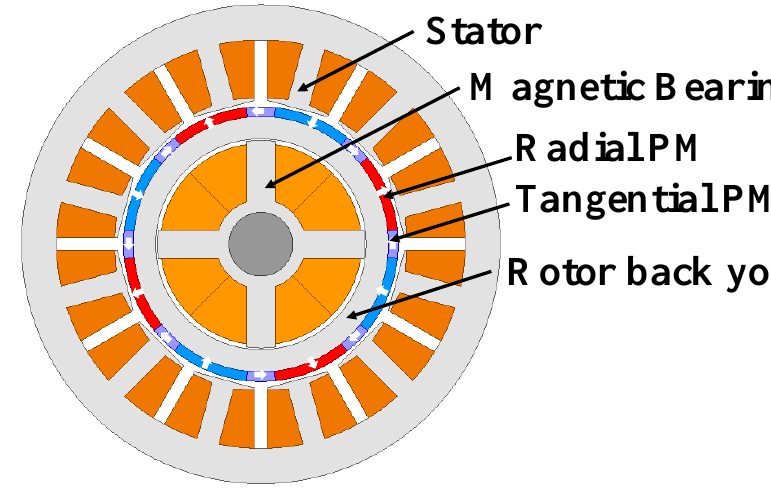
Figure 10. 2D cross section of basic model. Table 1. Specifications for the integrated magnetic bearing motor.